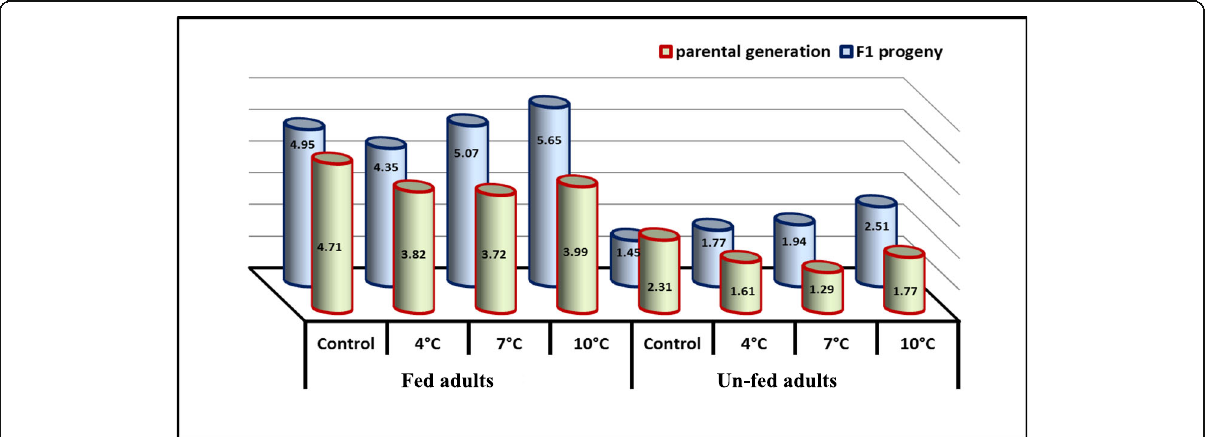
Fig. 2 Mean longevity of Trichogrammatoidea bactrae adults (fed and un-fed) of parental and F 1 progeny during storage of parasitoid pre-pupae at different low